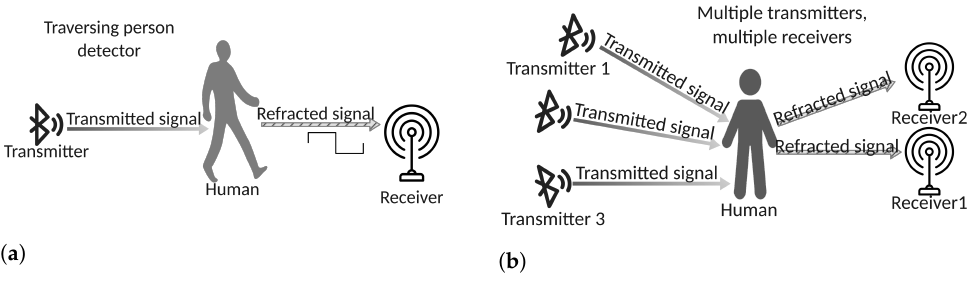
Figure 3. Moving humans counter and multi-transmitter, multi-receiver configurations. ( a ) Moving humans counter. The RSSI undergoes an abrupt change when a human body traverses the signal trajectory. ( b ) Multiple transmitters, multiple receivers.